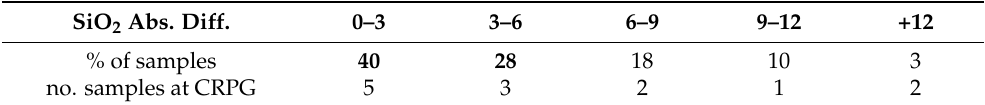
Table 2. Summary of the differences in silica content derived from ASTER GED using Equation (3) and measured in geochemical laboratories. Bold numbers highlight the percentage of best estimations. SiO 2 Abs. Diff. no. samples at